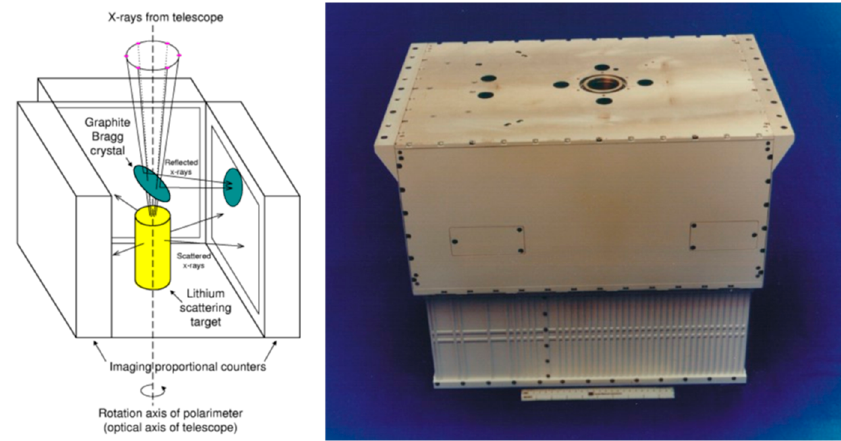
Figure 7. ( Left ) Concept of the SXRP. Incident X-rays focused from the telescope converge onto a thin graphite crystal. Higher-energy X-rays pass through the crystal and are scattered by a block of beryllium-covered lithium. The diffracted and scattered X-rays are detected by imaging proportional counters; ( right ) photograph of the completed device.